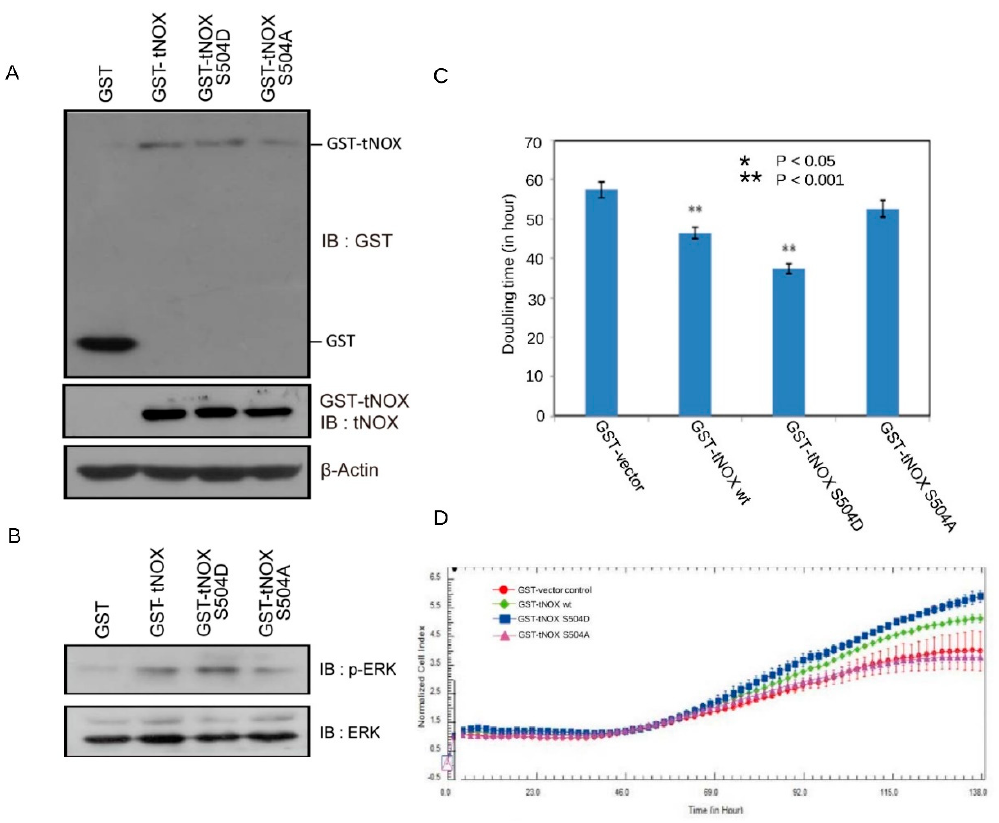
Figure 5. tNOX overexpression in NIH3T3 cells enhances cell growth. NIH3T3 cells were transfected